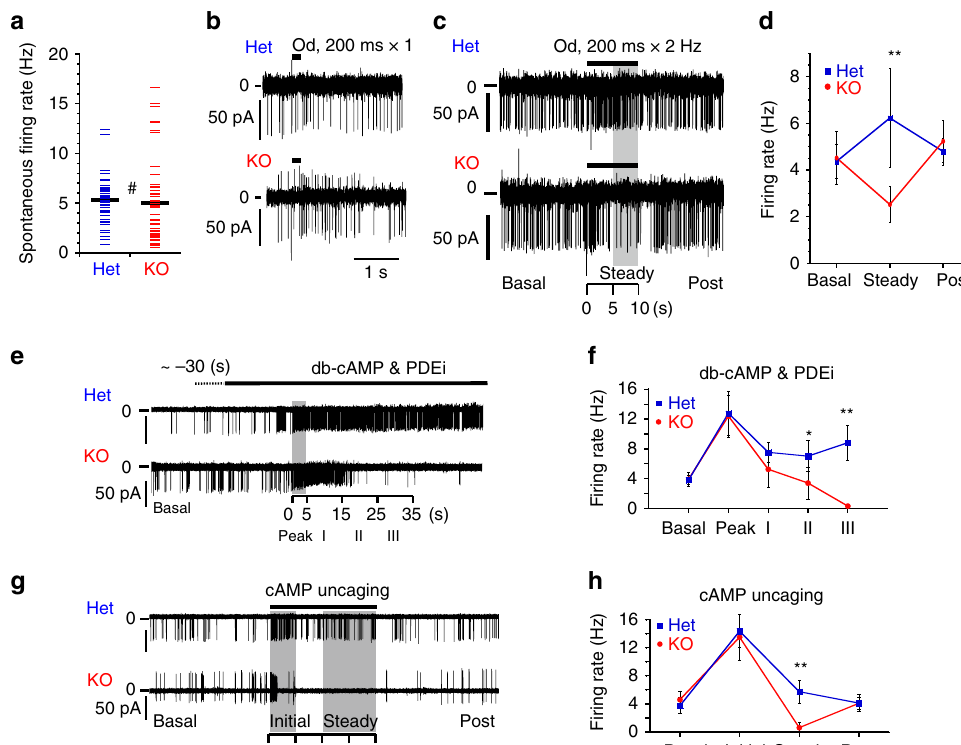
Fig. 4 OMP-KO neurons are silenced by repetitive stimuli. a Spontaneous fi ring rates of Het and KO neurons. Means: black bars. b Representative traces of fi rings induced by a single-odour stimulus in Het and KO neurons. Odourant mixtures contained amyl acetate, cineole, limonene, acetophenone, heptanal and lilial at a concentration of 100 μ M each. c Representative traces of fi rings induced by repetitive odour stimuli in Het and KO neurons. d Time courses of the average fi ring rates of Het and KO ORNs shown in ( c ). Steady indicates the period between 5 and 10 s in ( c ). e Representative traces of spontaneous fi rings of Het and KO neurons under the loose patch-clamp con fi guration in the presence of db-cAMP and PDEi. The grey bars indicate the region with maximal frequency after perfusion. f Time courses of the average fi ring rates of ORNs shown in ( e ). The peak was determined at the position of the maximal frequency within a 5-s bin after perfusion of the test solution; other segments were determined within 10-s bins. Mean ± s.d. g Representative traces of spontaneous fi ring of Het and KO neurons during UV uncaging of membrane-permeable cAMP. h Time courses of the fi ring rates of the ORNs shown in ( g ). The initial rate was determined within a 5-s bin; other segments were determined within 10-s bins. Statistics: a two-sided unpaired T test; P = 0.548 (#), n = 70 and 47 ORNs from three Het and three KO mice, respectively. d Two-sided unpaired T test; the P -values for basal, steady and post are 0.4, 0.007 and 0.2. n = 5, each. f Two-sided unpaired T test; the P -values for basal max, i, ii and iii are 0.89, 0.84, 0.11, 0.028 and 0.000039, respectively; n = 5 ORNs each from three Het or three KO mice. h Two-sided T test; the P -values for basal, initial, steady and post are 0.18, 0.58, 0.0000022 and 0.95, respectively; n = 7 Het neurons and 8 KO neurons from three mice each. Mean±